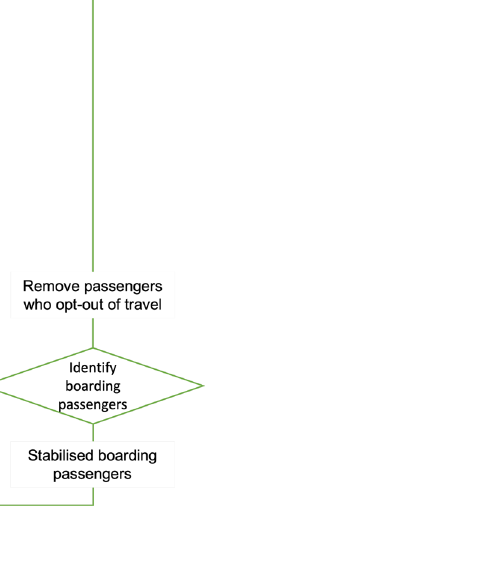
Figure 1. Summary of modelling